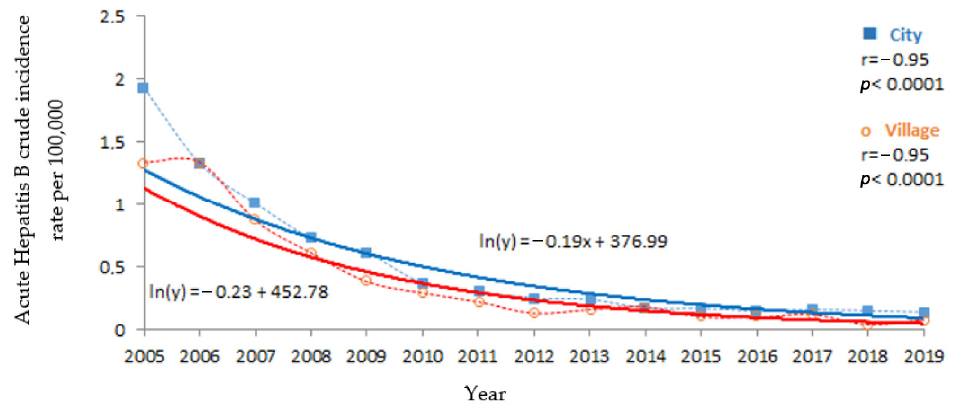
Figure 3. Acute Hepatitis B incidence trends amongst urban and rural residents in Poland, 2005–2019.